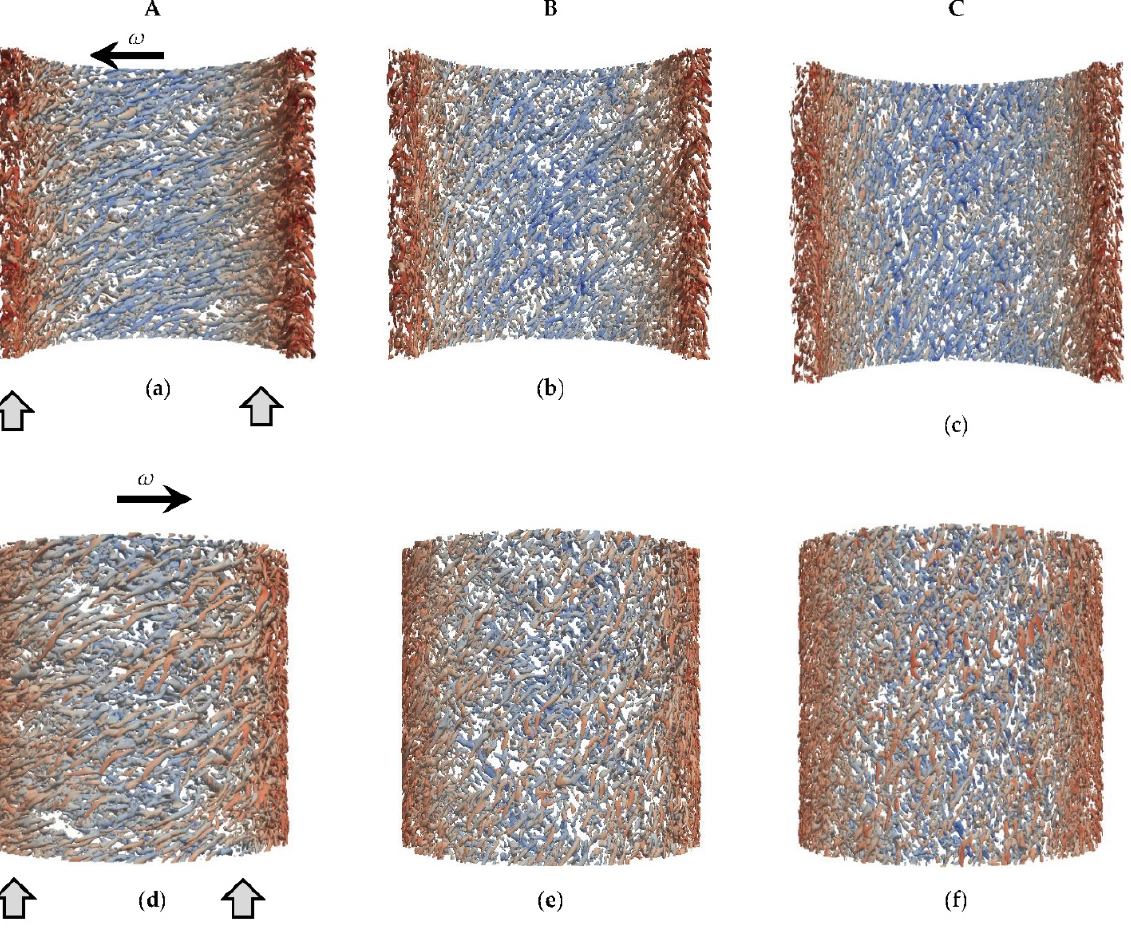
Figure 14. Iso-contours of the Q -criterion in the entire computational domain. ( a , d ) represent the iso-contours for case A, ( b , e ) for case B, and ( c , f ) for case C on the inner cylinder ( a – c ), as well as on the outer cylinder ( d – f ). ( a ) Q = 200, ( b ) Q = 500, ( c ) Q =